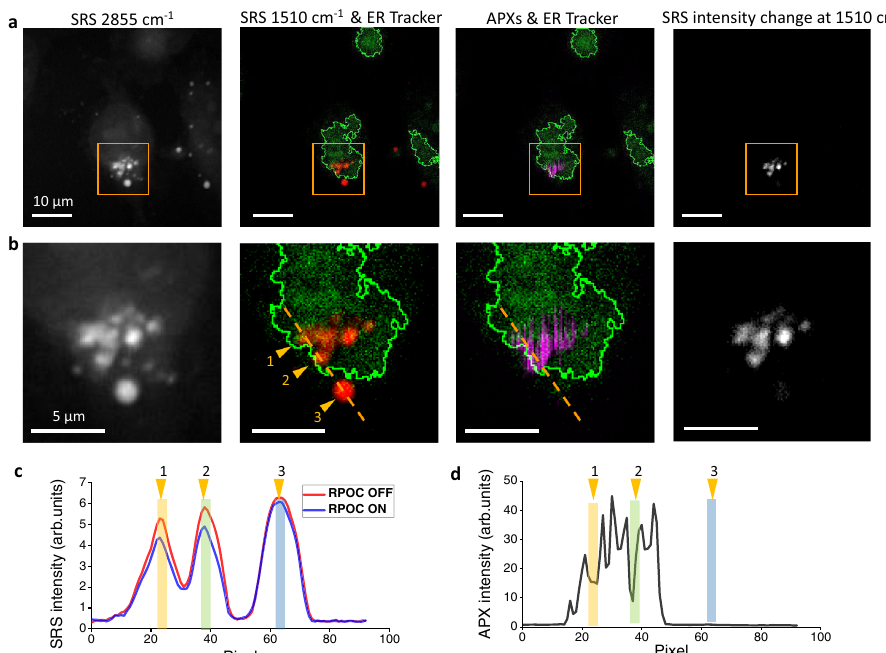
Fig. 6 | PrecisioncontrolofchemicalchangesbyRPOC using digitallogicfrom twodetectors.a Imagesof MIA PaCa-2 cellsshowing stimulatedRamanscattering (SRS) signals at 2855cm − 1 CH 2 stretching, the overlay of SRS signals from CMTE at 1510cm − 1 (red) and endoplasmic reticulum (ER) Tracker fl uorescence signals (green),theoverlayofactivepixels(APXs,magenta)andER-Trackersignals(green),